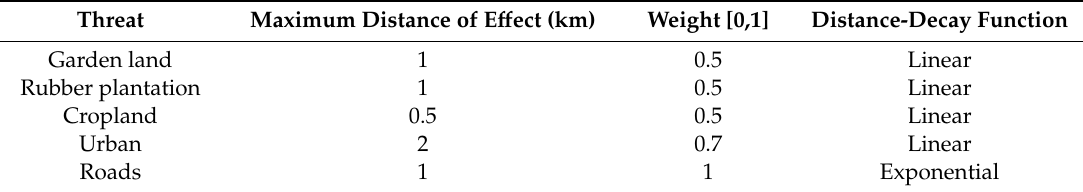
Table 1. Characteristics of threats to habitat quality in Hainan Island, China.